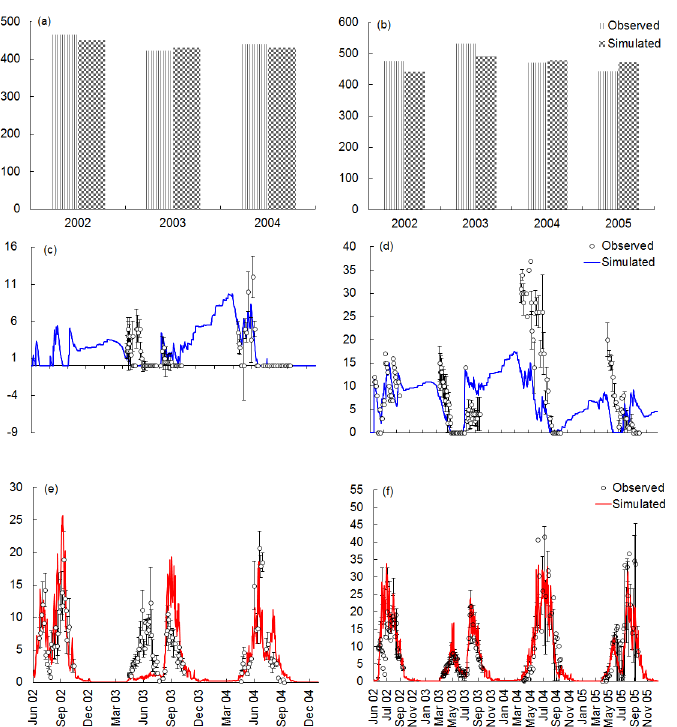
Fig 3. Comparison of simulated and observed annual aboveground net primary productivity by AVIM2. (a) for M-D site, (b) for M-C site. Comparison of simulated and observed seasonal patterns of water table depth and CH 4 fluxes on the Sanjiang Plain by EHM and CH4MOD wetland . (c) Water table depth and (e)